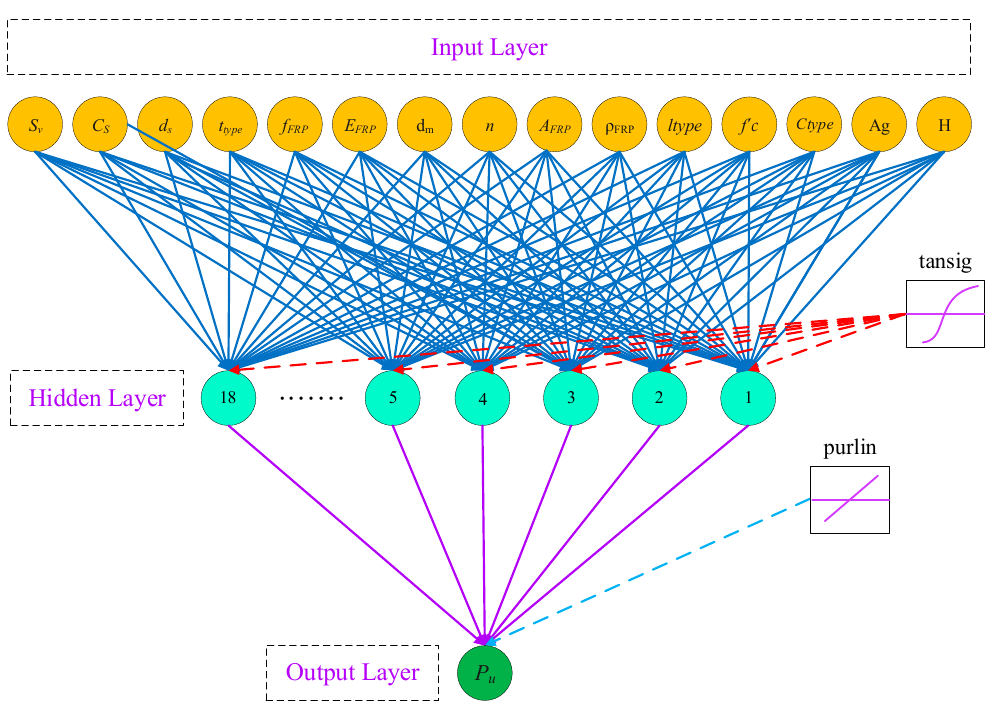
Figure 3. Structure of ANN with eighteen neurons in the single hidden layer.